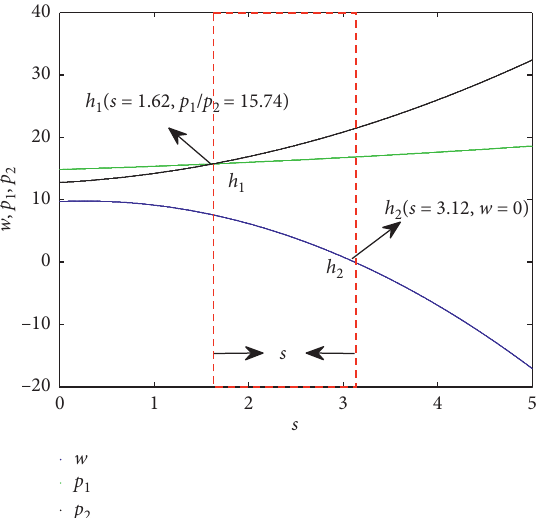
Figure 27: Profits of system ( 􏽑 ε